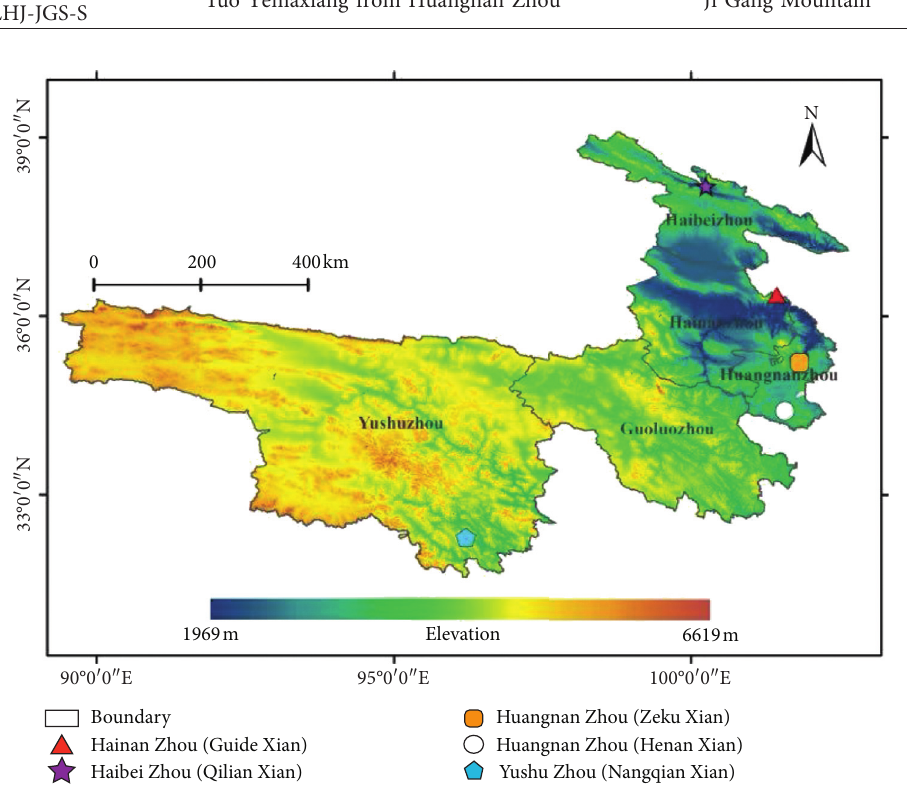
Figure 1: Areas of sample